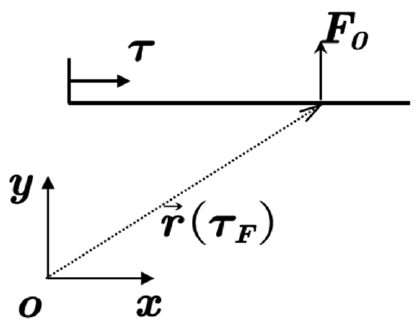
Figure 4. Degradation model of flexural vibration problem of elastic panel. For the structural part, since the sandwich structure is an assembly of several single plates and both the transverse and longitudinal displacements are expressed by the summa- tion of corresponding wave functions, the governing equations of the whole structure can be assembled based on the displacement compatibility conditions and force equilibrium conditions. A demonstration of the connection relations between five sub-plates is shown in Figure 5. According to the force–displacement relation, all the internal forces can be calculated by using the following